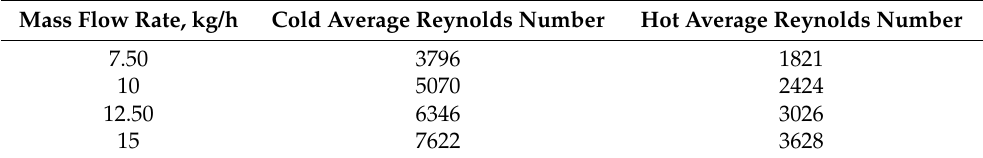
Table 6. The extended simulation conditions.